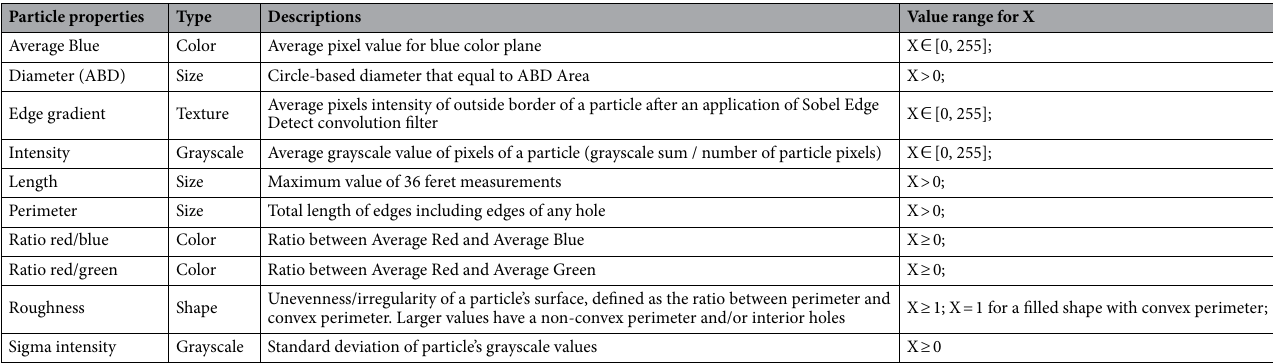
Table 1. List of particle properties with corresponding type, description and possible value range. (modified from FlowCAM user